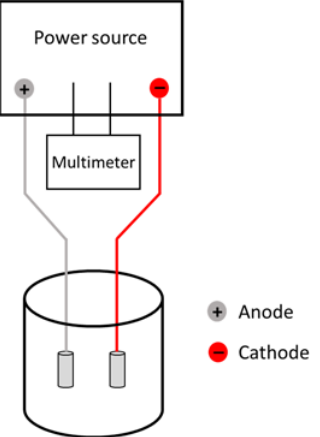
Figure 1 . Illustration of the two ‐ electrode experimental setup. Figure 1. Illustration of the two-electrode experimental